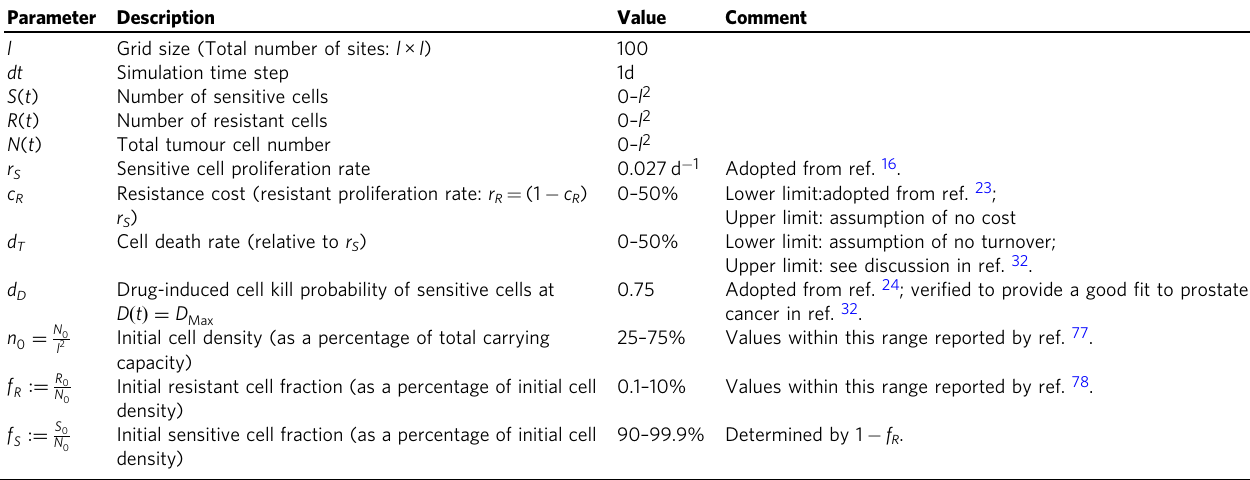
Table 1 Summary of mathematical model variables and